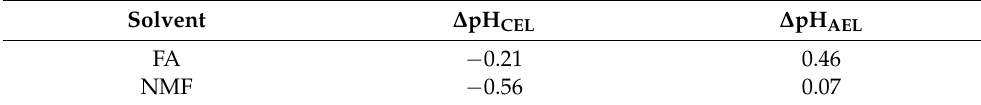
Figure 3. The pH change ( ∆ pH) in the solution phases on the CEL (solid circles) and AEL (open circles) sides after the 1 h BPMED as a function of current density: H 2 O ( • ), MeOH ( • ), EtOH ( • ), Et(OH) 2 ( • ), and FA ( • ). Table 3. The pH change ( Δ pH) for amide systems. Solvent